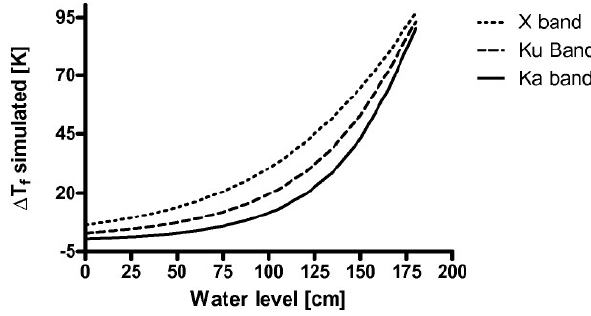
Fig. 6. Polarization difference in flooded marsh ( 1T f ) simulated as a function of water level at X, Ku and Ka